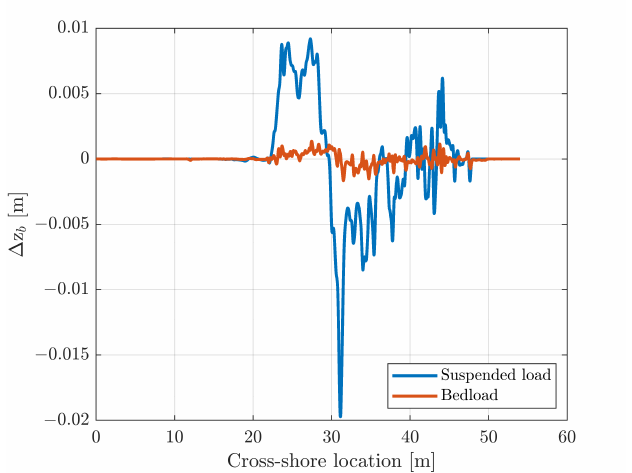
Figure 12. The relative contributions from bedload and suspended load to the total bed level change of the first modelled solitary wave. For clarity, the results have been smoothed using a Gaussian